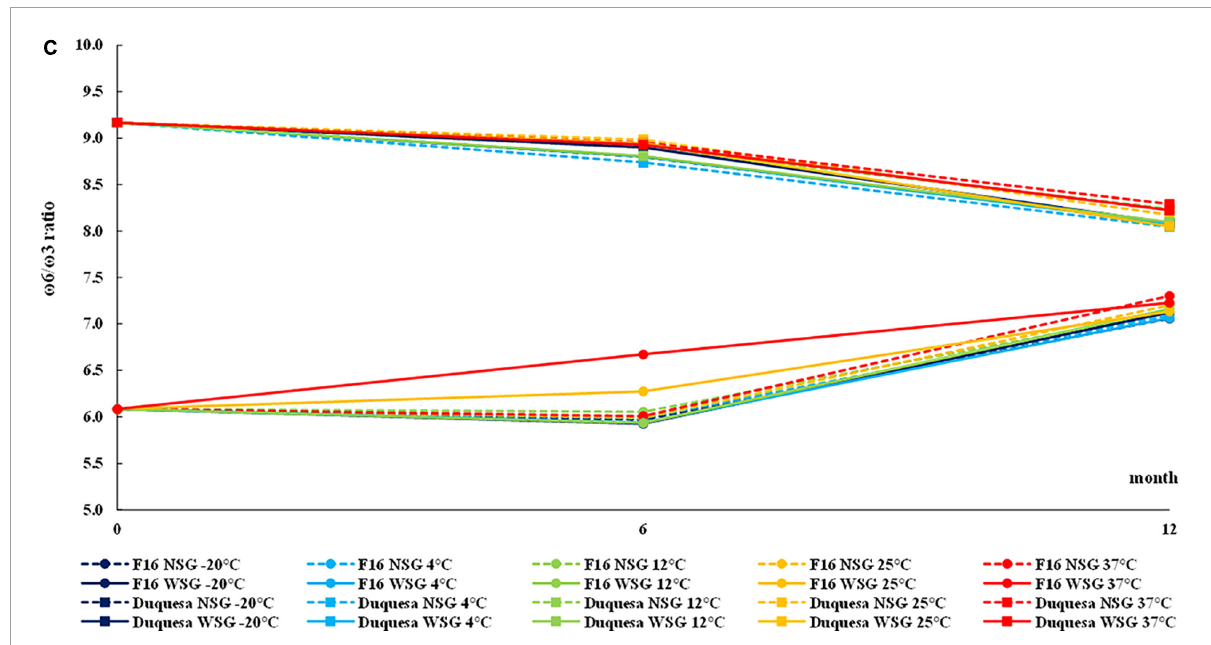
FIGURE3 Quinoa fat content and composition. (A) Evolution of seed fat content F16 seeds (circles) and Duquesa seeds (squares) stored at different temperatures and humidity conditions. (B) Average fatty acid profile F16 seeds (upper row) and Duquesa seeds (lower row) before storage (left), after 6 months of storage (middle), and after 12 months of storage (right). (C) ω -6/ ω -3 ratio in F16 and Duquesa seeds stored at different temperature and humidity conditions, where ω -6 is the sum of the linoleic and eicosadienoic acid relative contents and ω -3 is the α -linolenic acid relative content. NSG, seeds stored without silica gel; WSG, seeds stored with silica gel; C14:0, myristic acid; C15:0, pentadienoic acid; C16:0, palmitic acid; C17:0, margaric acid; C18:0, stearic acid; C20:0, arachidic acid; C22:0, behenic acid; C16:1, palmitoleic acid; C17:1, margaroleic acid; C18:1, oleic acid; C20:1, gadoleic acid; C22:1, erucic acid; C18:2, linoleic acid; C18:3, α -linolenic acid; C20:2, eicosadienoic